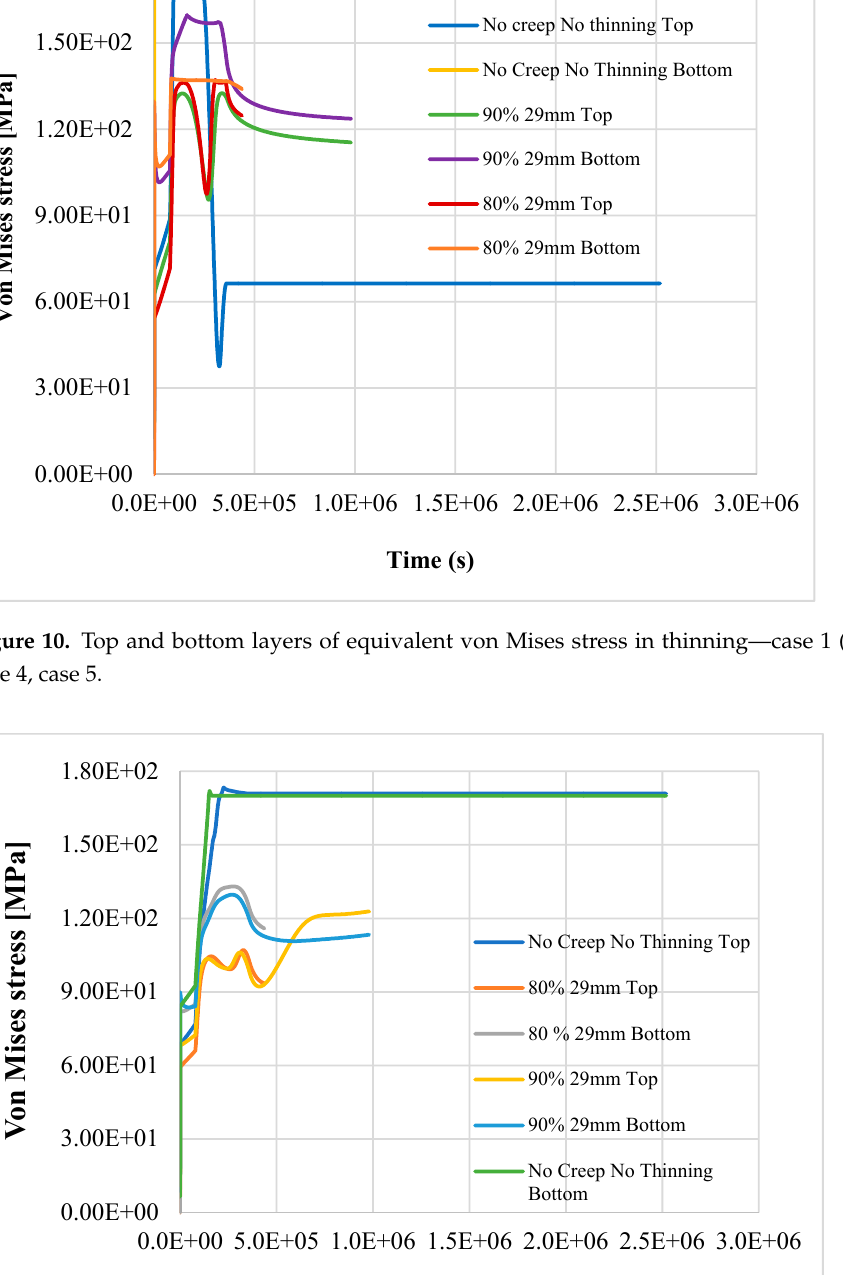
Figure 11. Top and bottom layers of Equivalent von Mises stress in thinning—case 1 (reference), case 4, case 5.